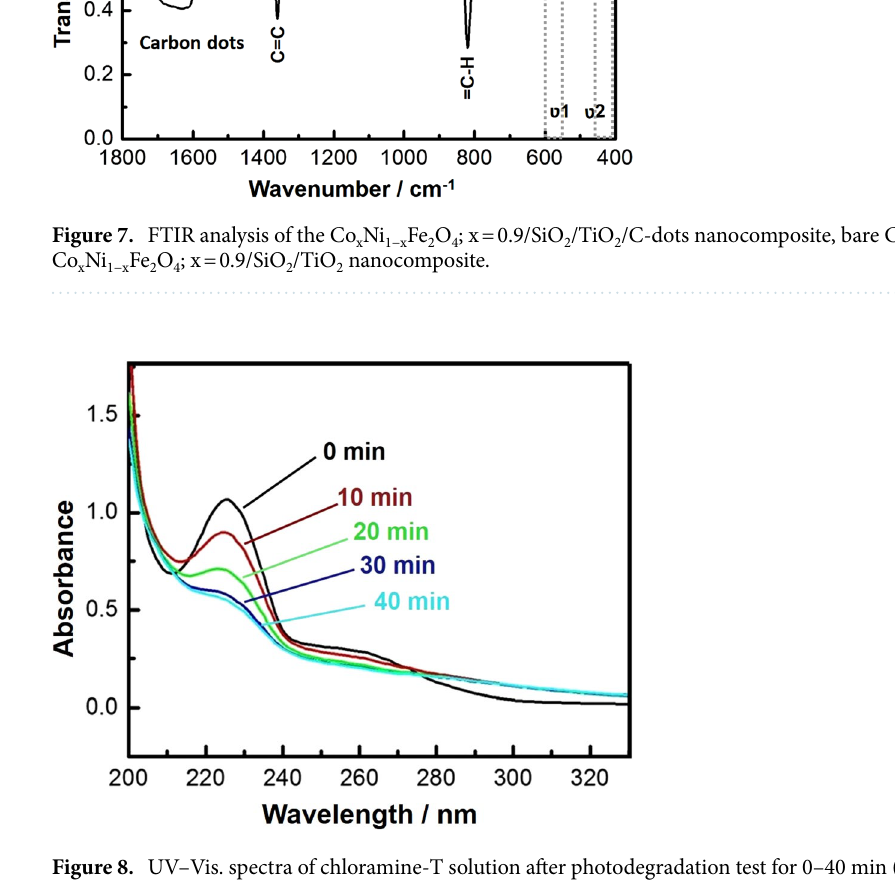
Figure 8. UV–Vis. spectra of chloramine-T solution after photodegradation test for 0–40 min (10 mg of nanocomposite, 50 ml chloramine-T solution, Temp. = 25 °C and pH